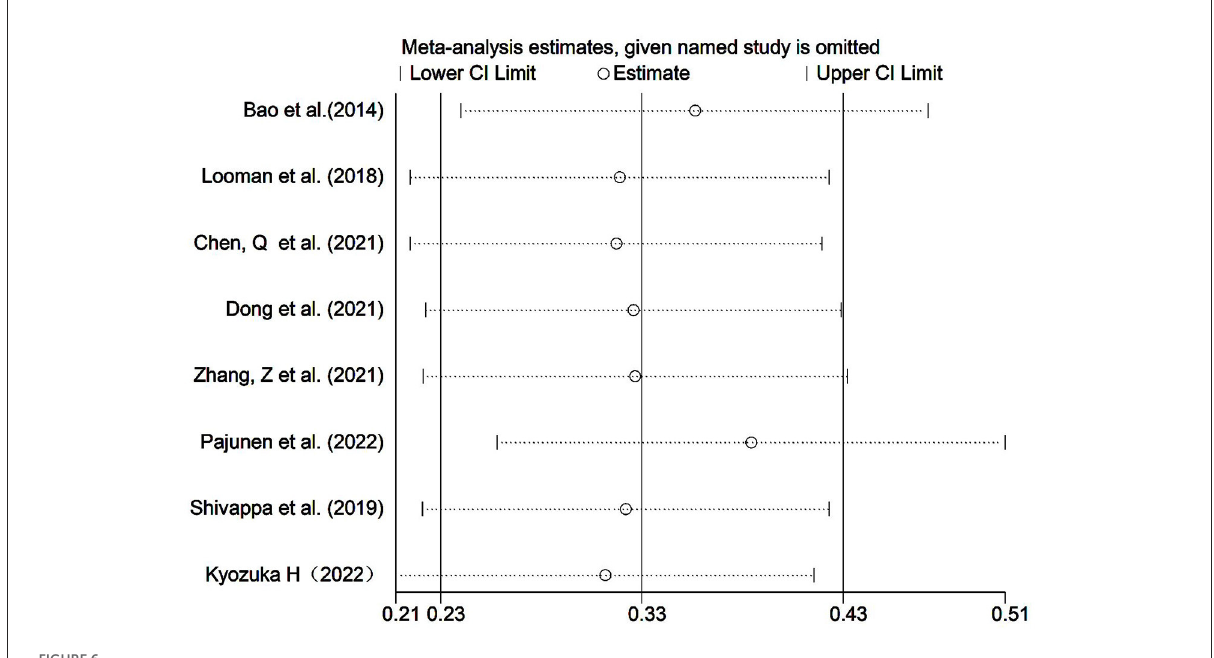
FIGURE6 Group B sensitivity